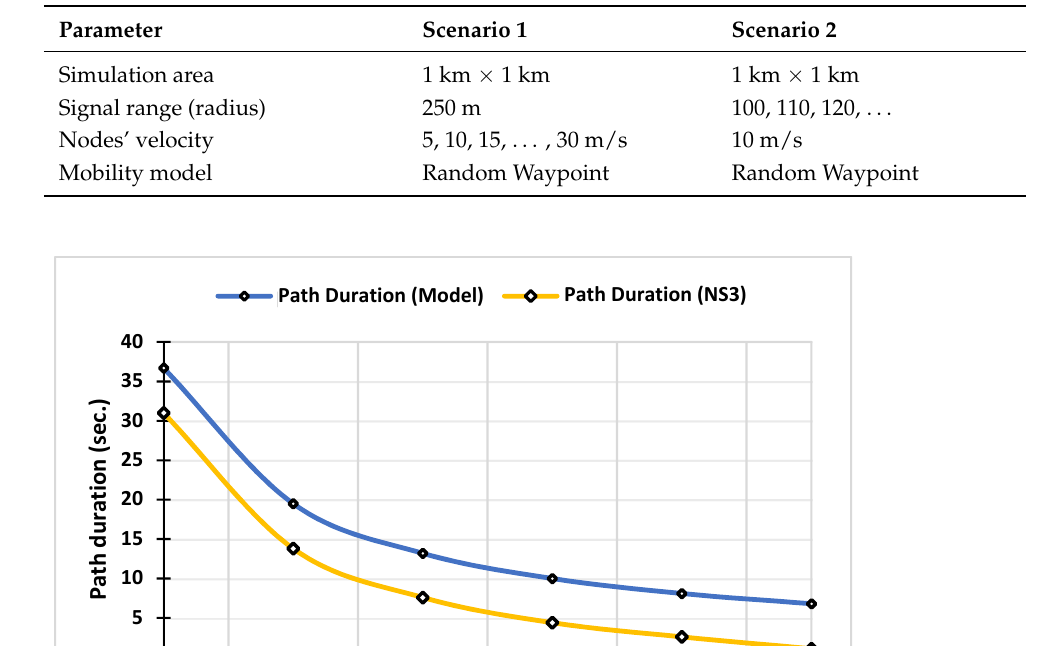
Figure 10. Utilization ratio of the path duration vs. the velocity of the node. From Figure 10, it is assumed that the periodic update time is 15 s, which is the de ‐ fault value used by the NS3 simulation environment. It is observed that the utilization rate of the DSDV path duration decreases as the velocity of the nodes increases. This is because the path duration decreases with the increase in nodes’ velocity, while the periodic update remains constant. Figure 11 illustrates the relationship between the number of hops and the path dura ‐ tion. It is shown that the path duration is inversely proportional to the hop count, and it is considerably decreased when the hop count is greater 4. It is also noted that the actual path duration (Model) is greater than the observed DSDV path duration (NS3), and this difference increases with increasing the hop count metric. Furthermore, the path duration